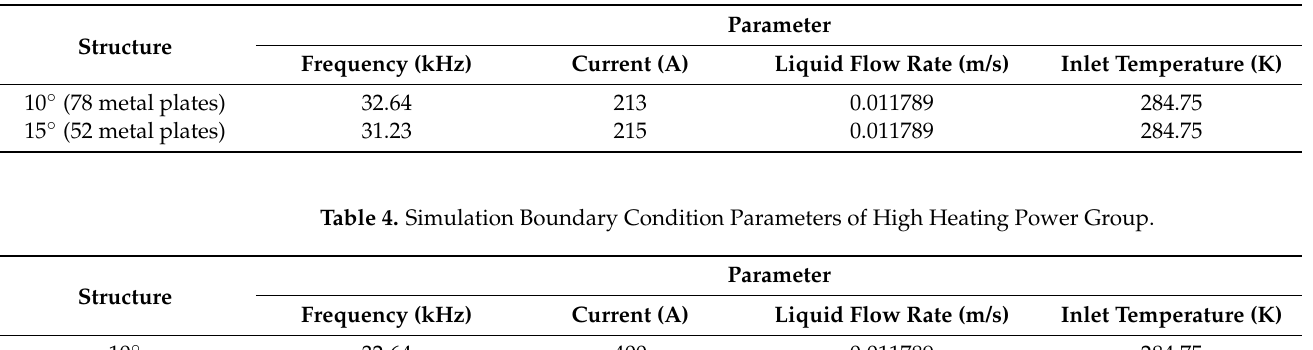
Table 3. Simulation Boundary Condition Parameters of Low Heating Power Group.